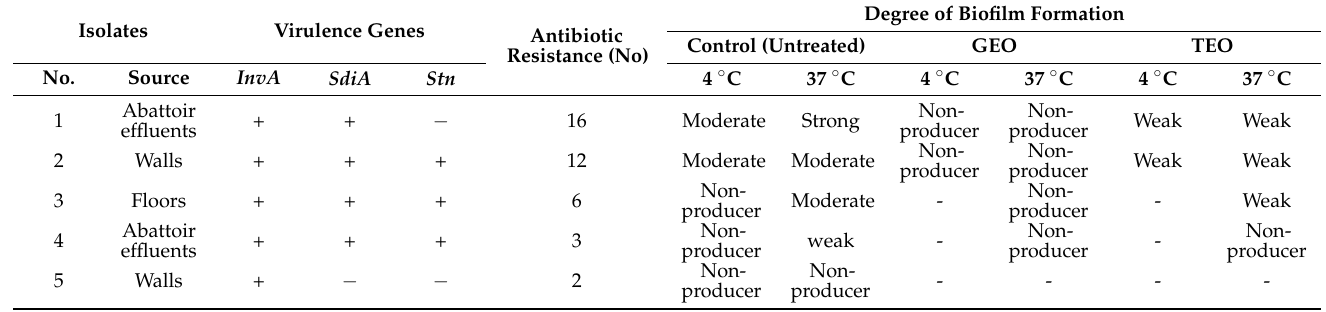
Table 6. Virulence genes, antibiotic resistance, and biofilm-forming capability of S. typhimurium